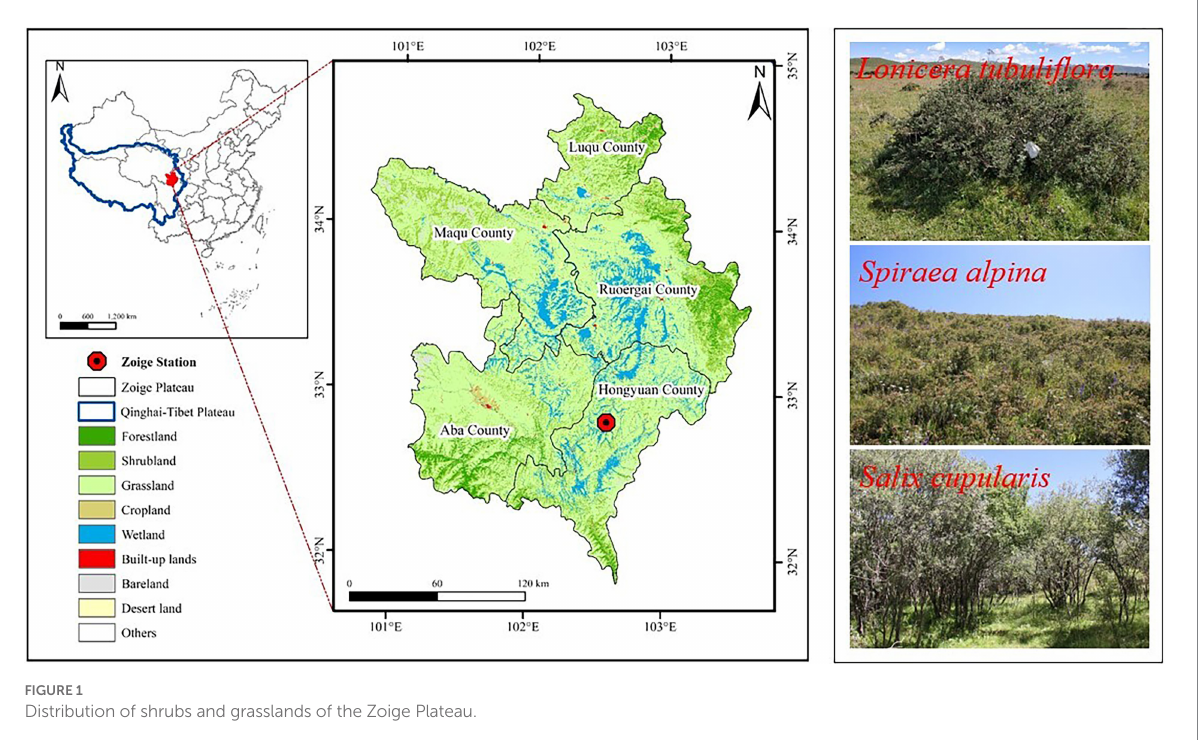
FIGURE 1 Distribution of shrubs and grasslands of the Zoige